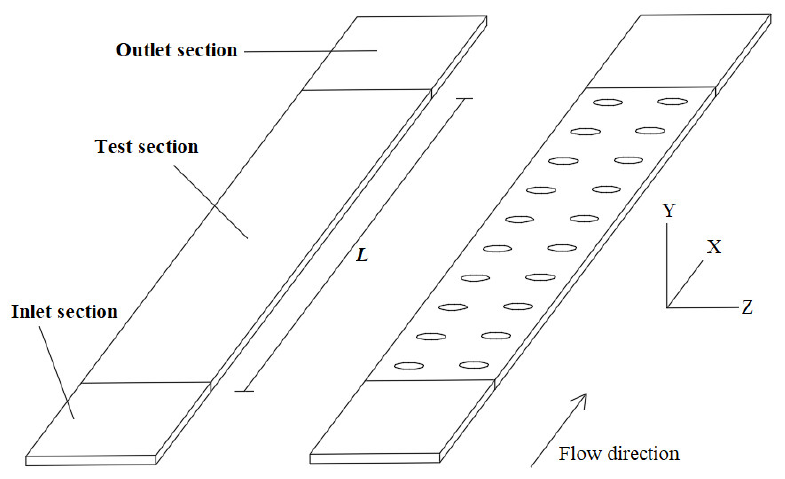
Figure 3. Microchannels with and without protrusions (smooth and roughened channels).